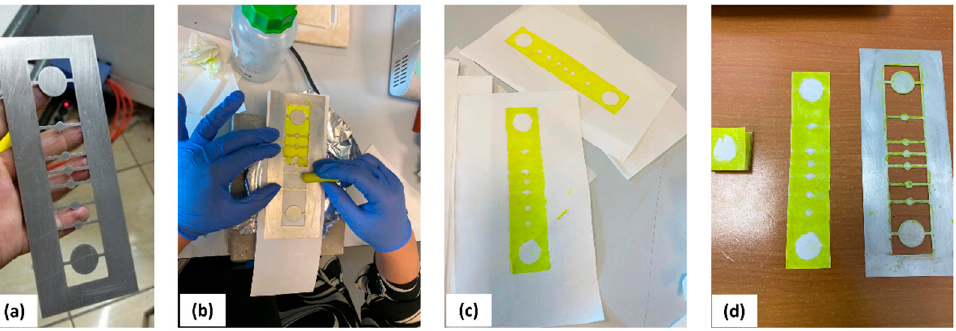
Figure 2. Fabrication process for 3D-PMED. ( a , b ) Coating cellulose paper with wax (crayon) on a heated surface, so only the exposed areas remain hydrophilic; ( c , d ) 3D PMED with sweat collector on one end and sweat evaporator on the other (both